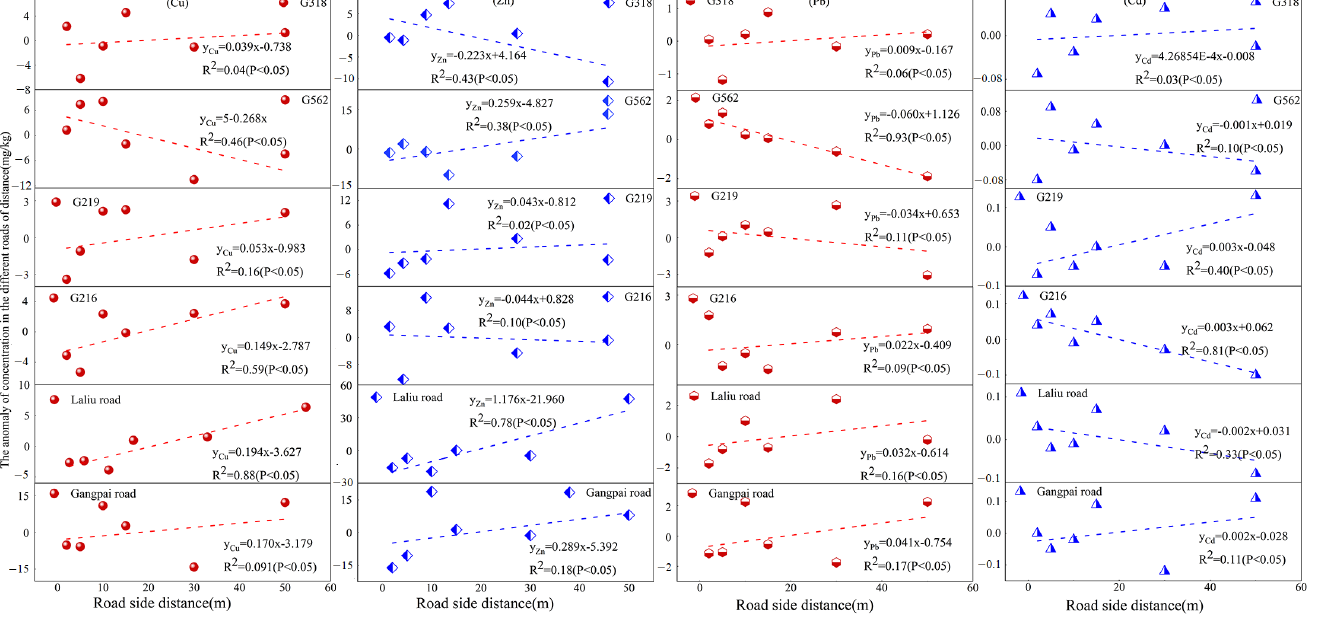
Figure 2. Soil heavy metal contents in relation to distance from the road. Table 5. Descriptive statistics of soil heavy metal concentrations (mg·kg − 1 ) and their distributions near different types of roads.